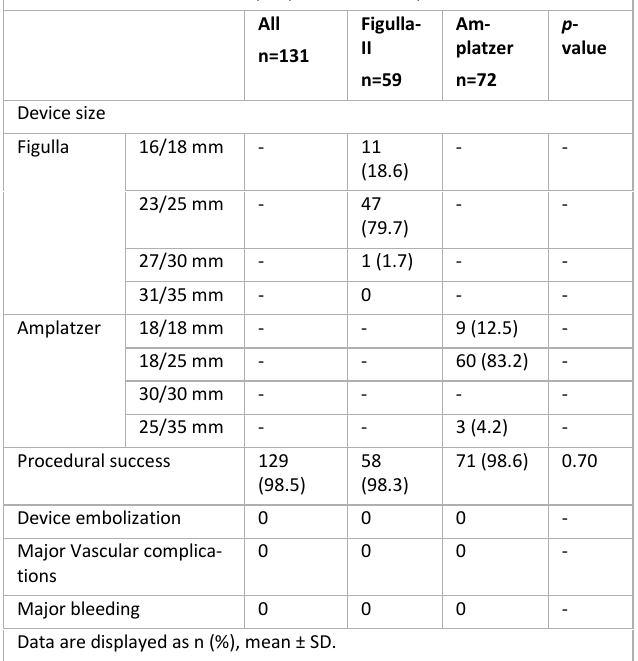
Table 1. Procedural data and periprocedural complications All